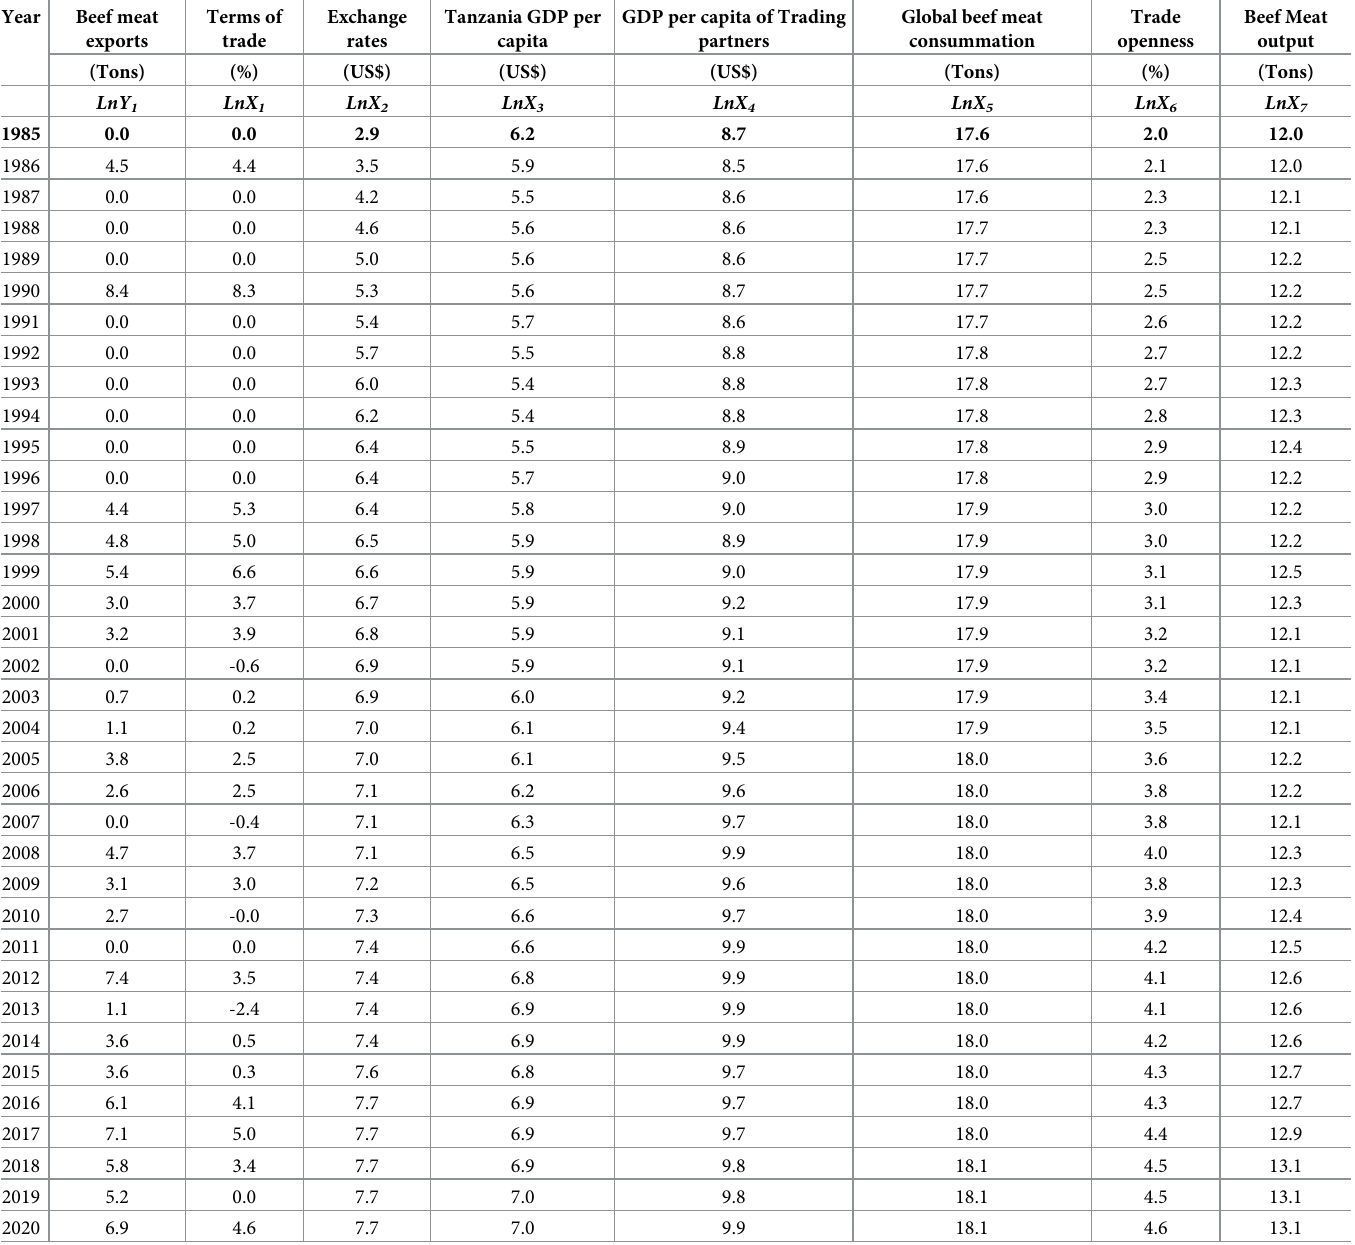
Table 3. Dataset converted into natural logarithm ( Ln